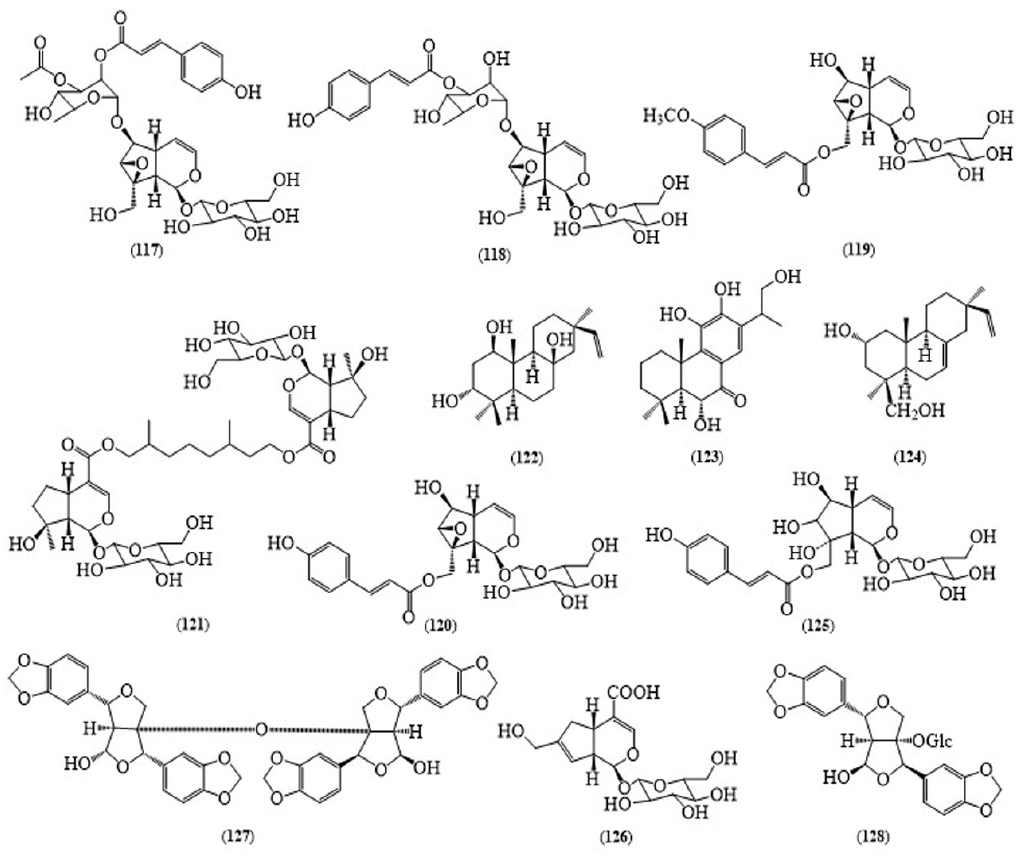
Figure 11. Structures of selected compounds isolated from Premna integrifolia.